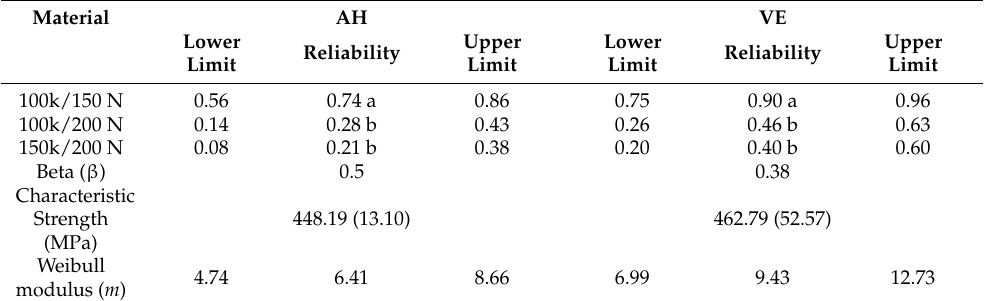
Figure 5. Contour plot: Weibull modulus vs. characteristic resistance (the red contour shows the results for the AH material and the blue contour for the VE material). Table 3. Reliability for missions of 50,000 cycles according to load; upper and lower limits (90% confidence interval).